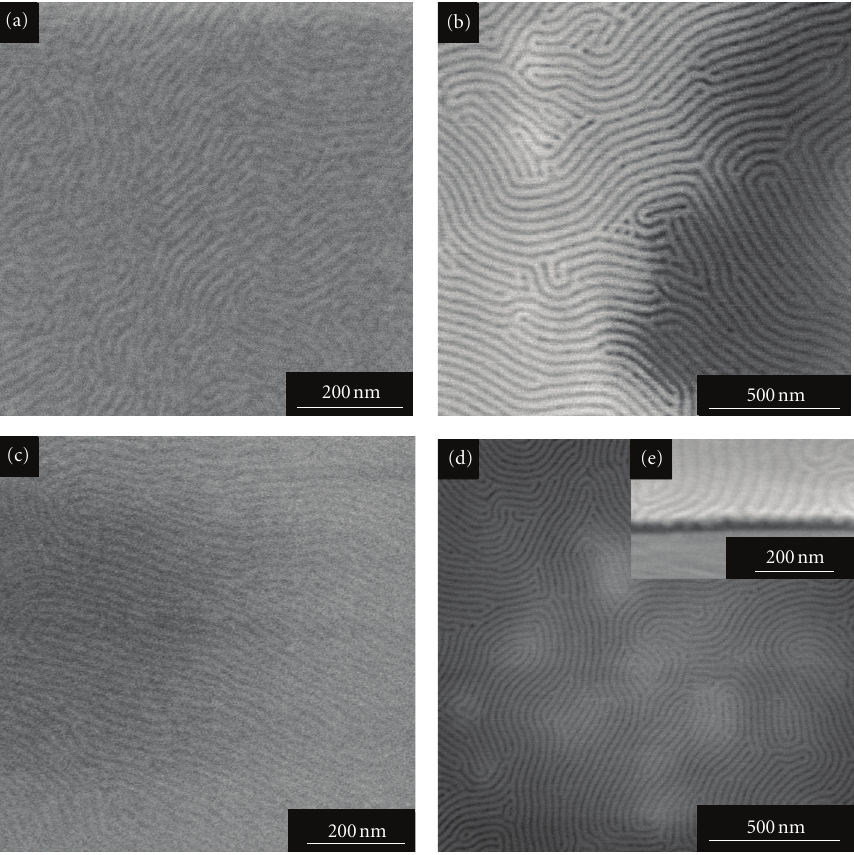
Figure 9: SEM images of thin films (a) PMAPOSS- b -PMAHFC 1 , (b) PMAPOSS- b -PMAHFC 2 , (c) oxygen plasma treated PMAPOSS- b - PMAHFC 1 , and (d) oxygen plasma treated PMAPOSS- b -PMAHFC 2 , the inset (e) is the cross-sectional SEM image of (d). Table 1: Characteristics of block copolymers based on SEC and 1 H NMR analyses.